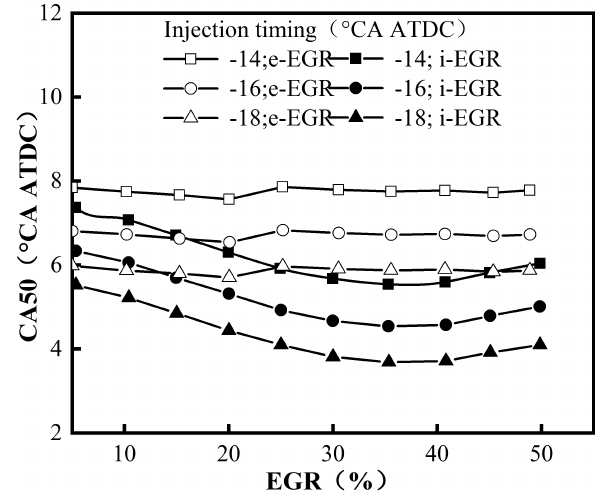
Fig. 7 Effects of i-EGR and e-EGR ratios on